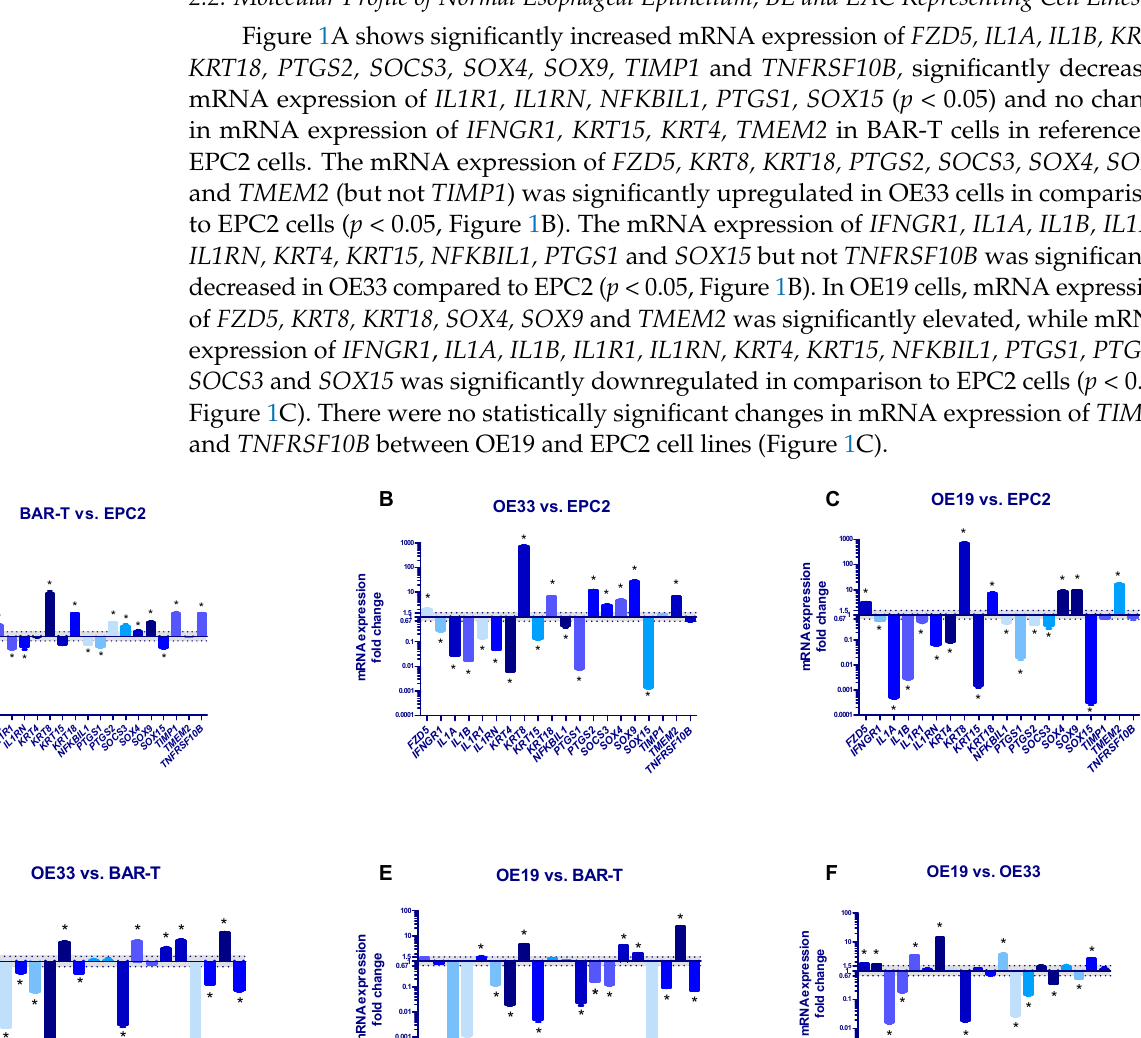
Figure 1. Alterations in molecular profile of BAR-T, OE33 and OE19 cells representing subsequent stages of Barrett’s esophagus (BE) and esophageal adenocarcinoma (EAC) development. ( A – C ): mRNA fold change for selected genes was normalized to the basal expression for EPC2 cell line; ( D , E ): results are normalized to the basal expression for BAR-T cells; ( F ): mRNA expressions in OE19 are normalized to the values observed in OE33 cells. Dotted lines indicate 1.5-fold up-/downregulation of mRNA expression compared to the reference cell line. Results shown as the mean ± SEM of 3 values per group for each gene. Statistically and biologically significant differences compared to reference cell line are indicated by asterisk (*) ( p < 0.05).